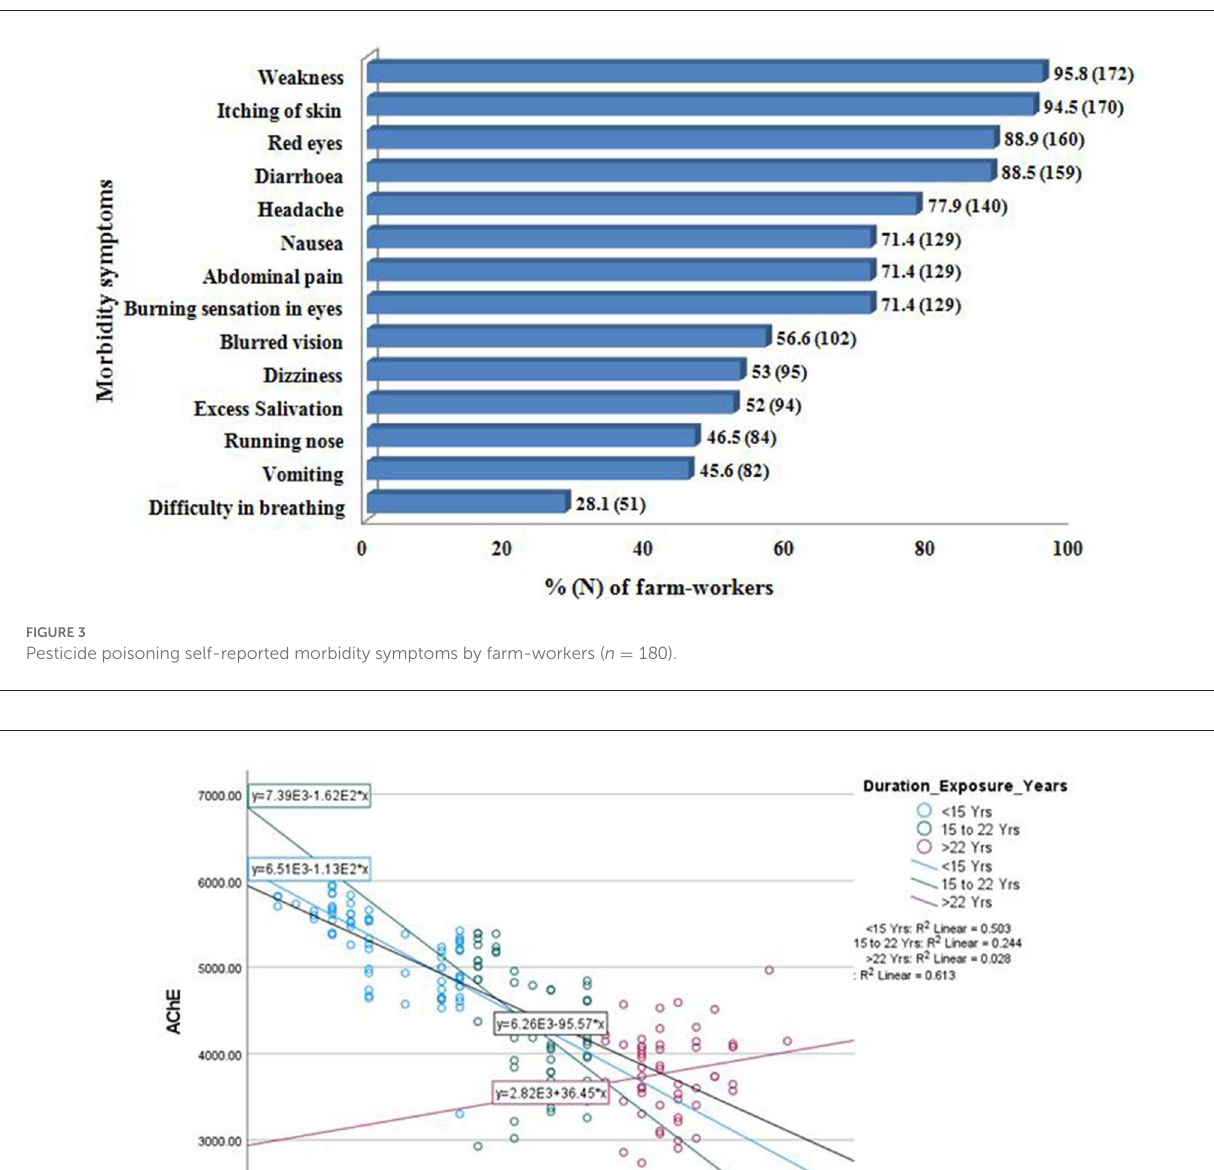
shoes; while rest (38%) wore short sleeved shirt, lungi (sarong) and slippers. On the other hand, all the farm women wore saree (Indian traditional wear) and slippers with a long sleeved shirt over the saree in order not only to cover themselves but also to protect themselves from exposure to heat. Further, some of the farm men also explained that they do spray pesticide formulations with bare body occasionally to avoid the heat stress. Further, 99% of farm-workers were not using PPE of their own while handling